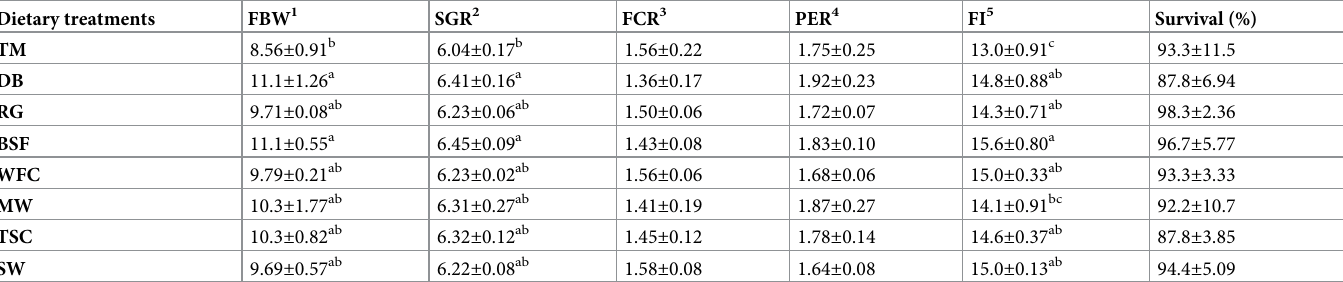
Table 8. Growth performance, feed utilization and survival of Pacific white shrimp ( Litopenaeus vannamei ) (initial body weight: 0.17 ± 0.00 g) fed the experimental diets for 65 days. Dietary treatments